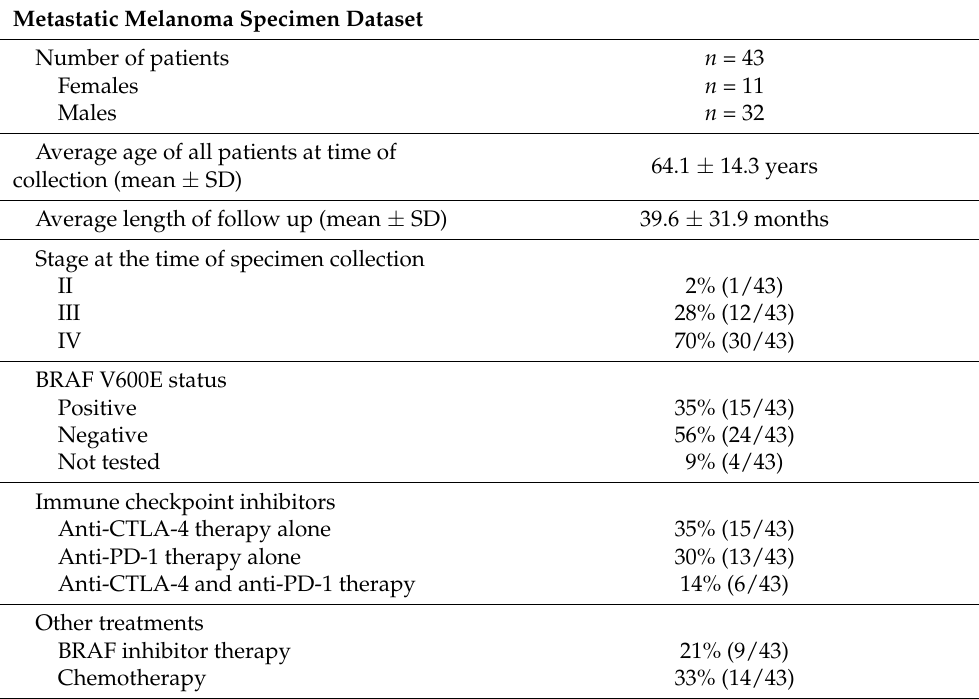
Table 2. Demographics of patients in the metastatic melanoma clinical